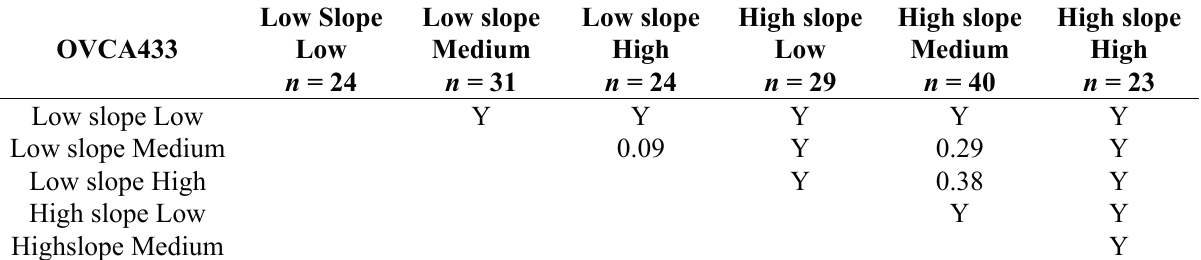
Figure 3. Merged migration speed data for the four cell lines on the low and high slope gradients. The statistical analysis for each cell line is given in Tables 1–4. The data shows the relative roles of local concentration and slope on the haptotaxis response of the cell lines. Error bars represent standard error. Table 1. p values from pair-wise t -tests of migration speeds of OVCA433 cells at low, medium, and high concentration regions of the low and high slope LN gradients. n = number of cells used in the analysis. In lieu of explicit p values, we denote “Y” (yes) as statistical differences corresponding to p < 0.05 to better visualize trends.